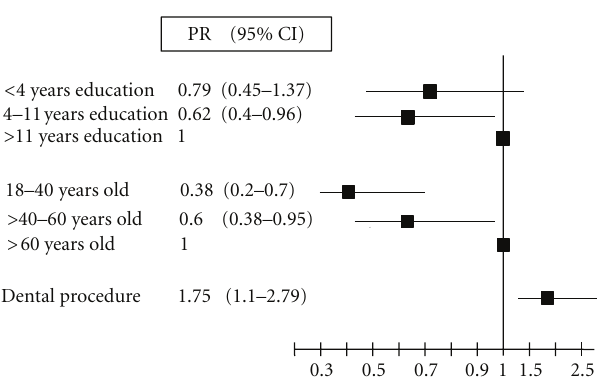
Figure 1: Prevalence ratio for genotype type 2 in patients with hepatitis C in southern